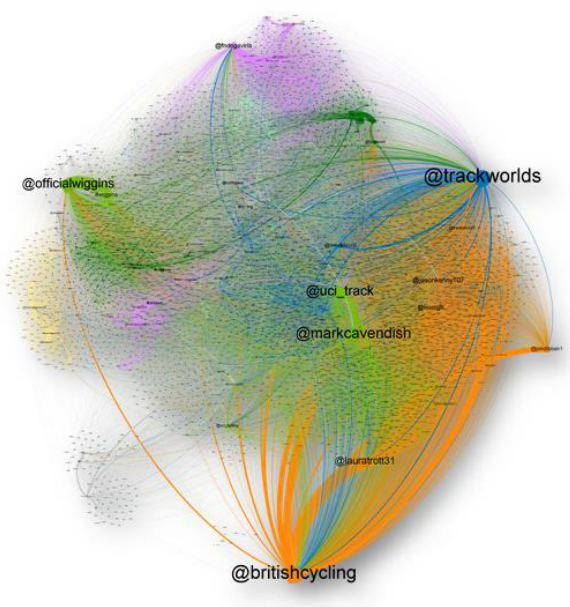
Figure 1. Interaction graph during the Twitter conversation with the hashtag #TWC2016.